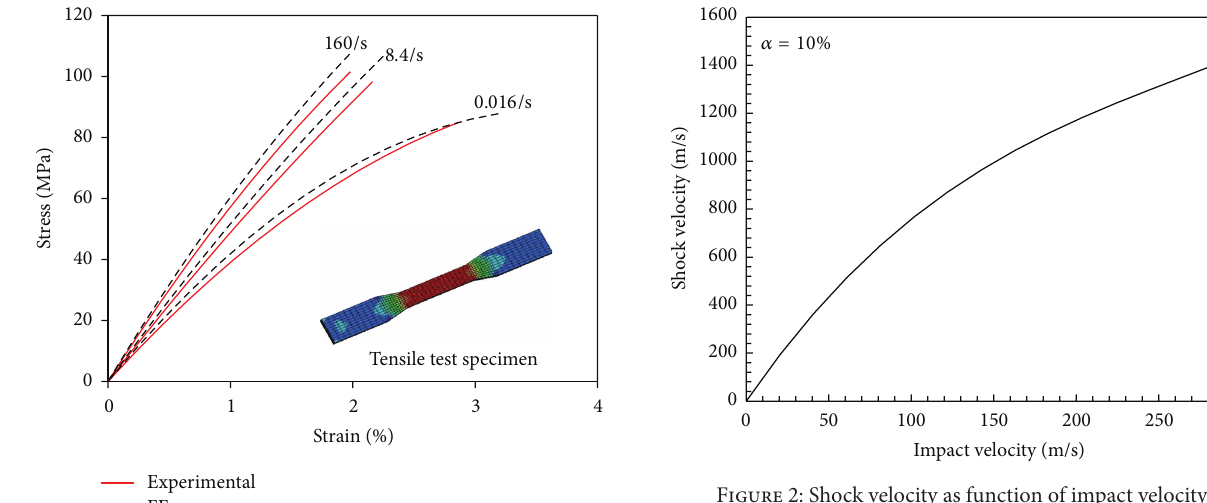
Figure 2: Shock velocity as function of impact